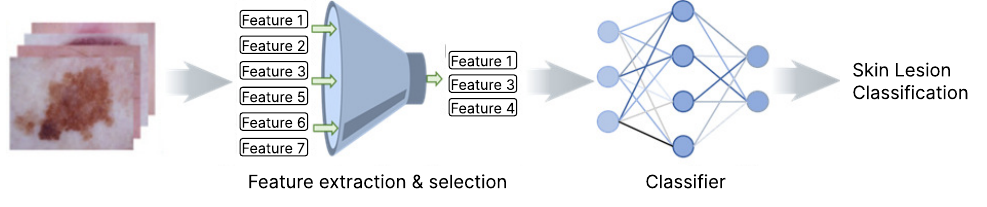
Figure 4. Traditional ML-based skin lesion